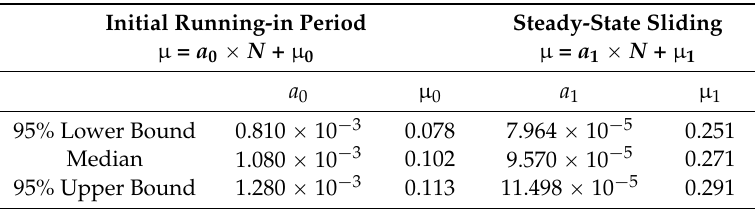
Table 1. Mathematical model and its estimated parameters for description of the initial running-in period and the steady-state sliding (Case of 25 N normal force with 1 mm displacement and 1 Hz